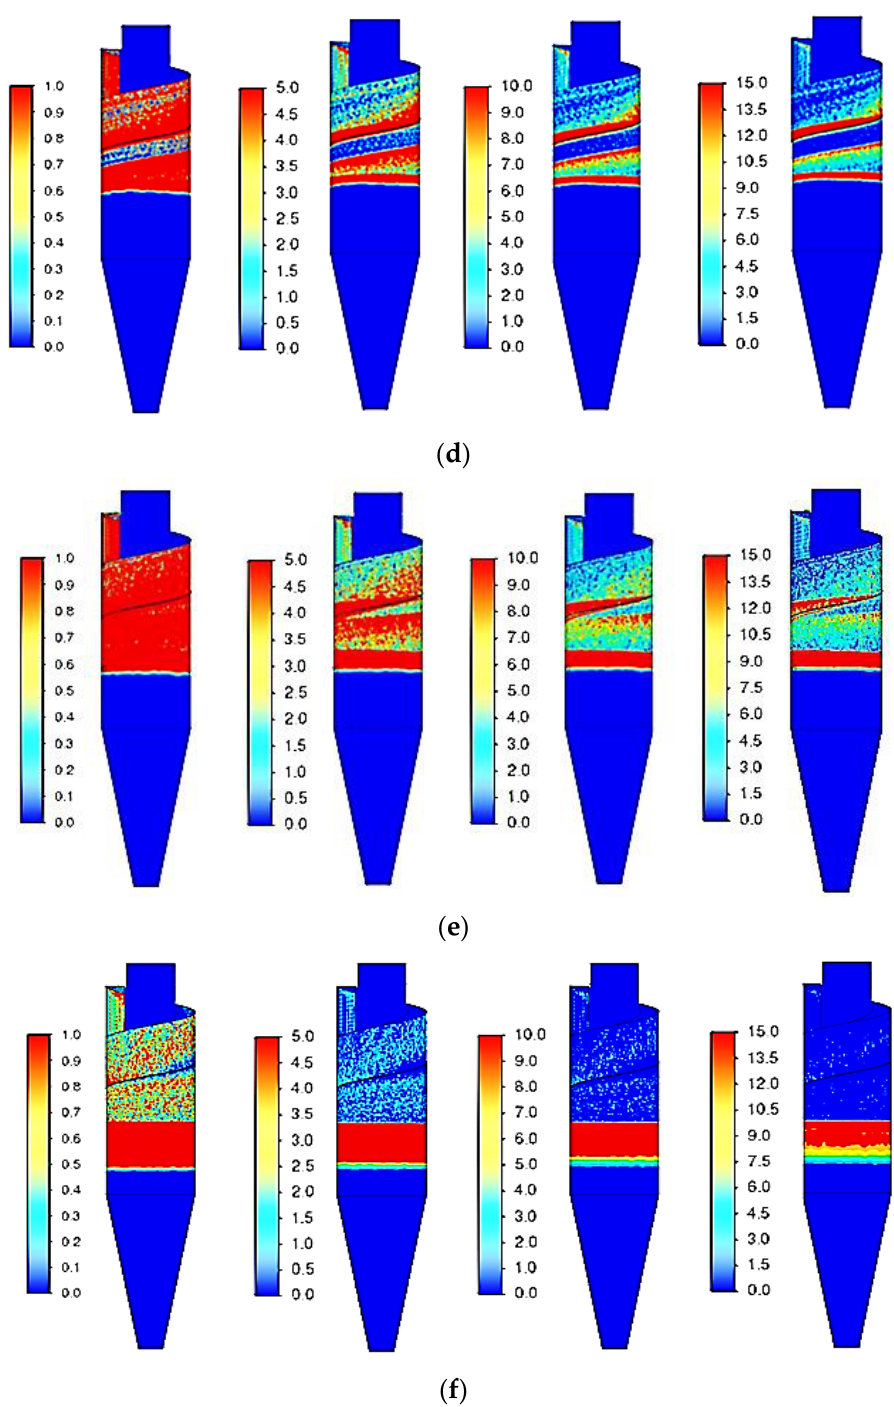
Figure 5. Erosive wear regions in the cyclone at different particle diameters ( d p ). The legend shows the numeric value of the erosive wear rate We, mm/year: 0 – 1.0 mm/year; 0 – 5.0 mm/year; 0 – 10.0 mm/year; and 0 – 15.0 mm/year. ( a ) d p = 20 µm. ( b ) d p = 25 µm. ( c ) d p = 40 µm. ( d ) d p = 60 µm. ( e ) d p = 100 µm. ( f ) d p = 160 µm.